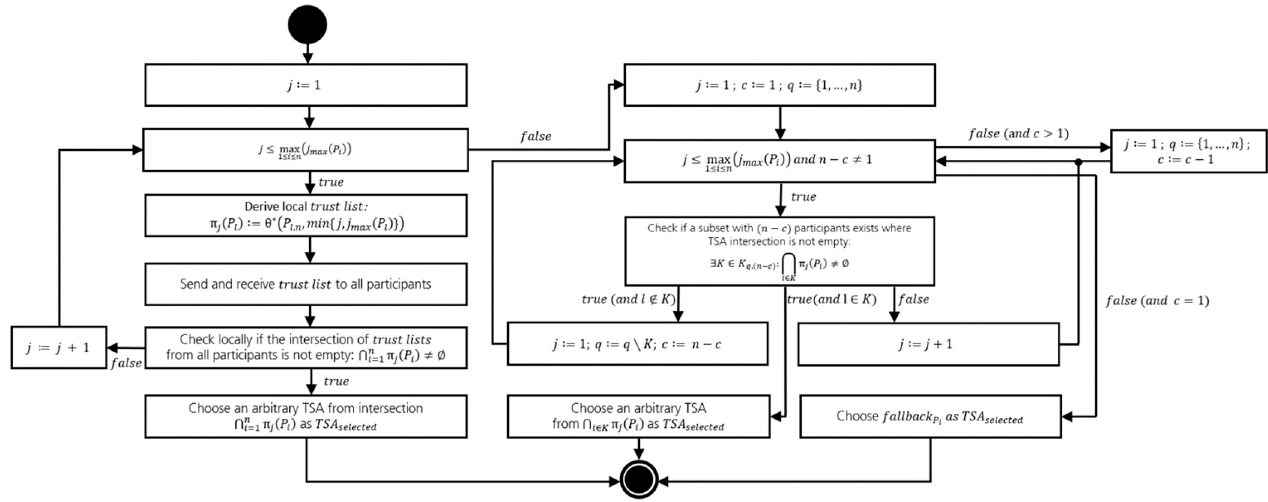
Figure 4. Negotiation Protocol for the agreement on a trusted TSA between different participants.